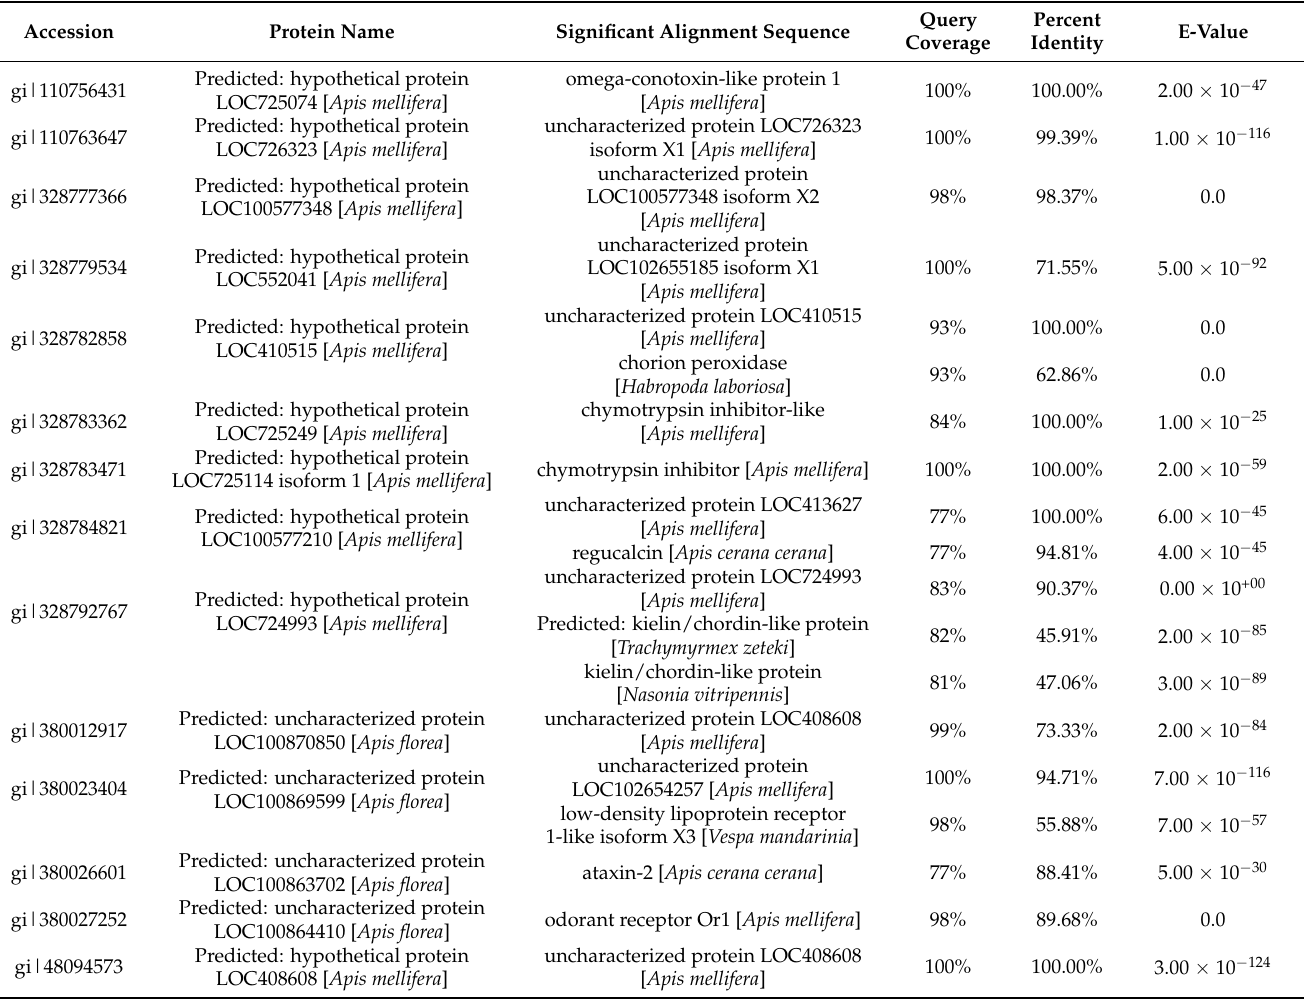
Table 2. Results of BLAST